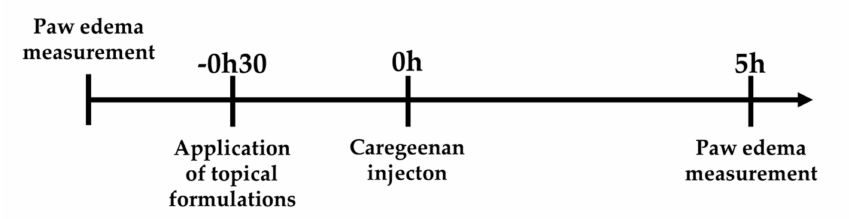
Figure 1. Carrageenan edema model time